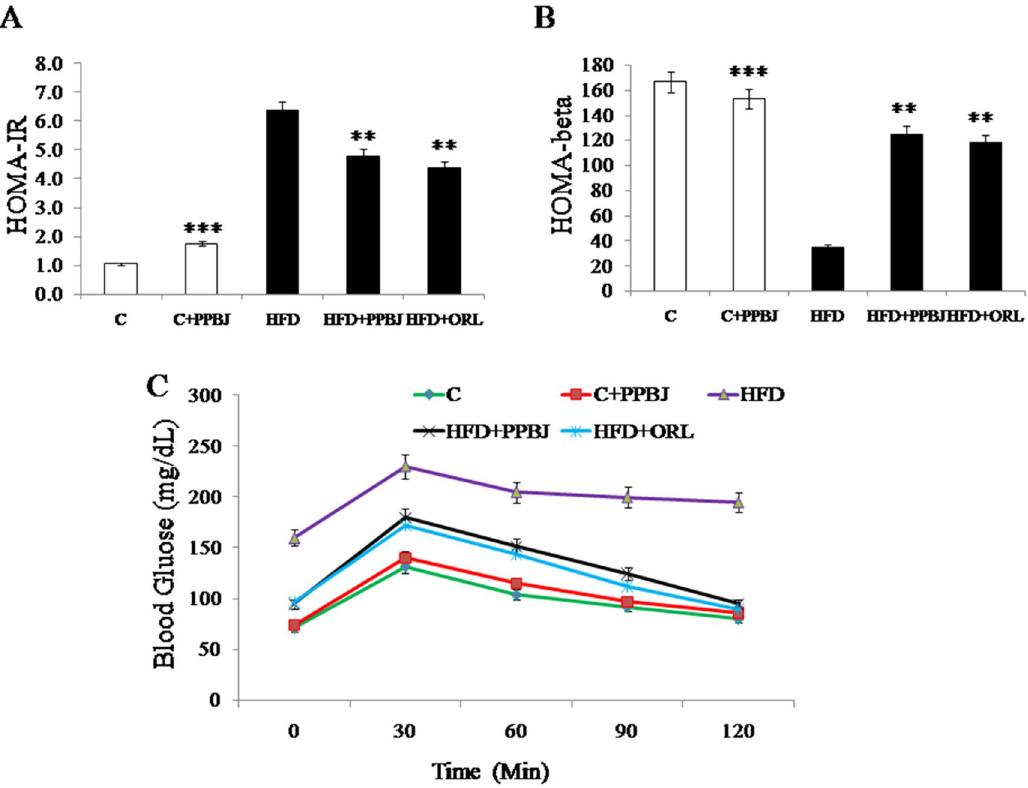
Figure 5. Effect of PPBJ on Insulin resistance. ( A ) HOMA-IR. ( B ) HOMA-beta and ( C ) OGTT. HOMA-IR homeostasis model assessment of insulin resistance; HOMA-beta homeostasis model assessment of β-cell function. OGTT oral glucose tolerance test; ORL Orlistat. Data was presented as Mean ± SEM (n = 6 each group). Statistically significance compared to their respective controls ***p < 0.001; **p < 0.01; *p < 0.05 . Groups compared using one way